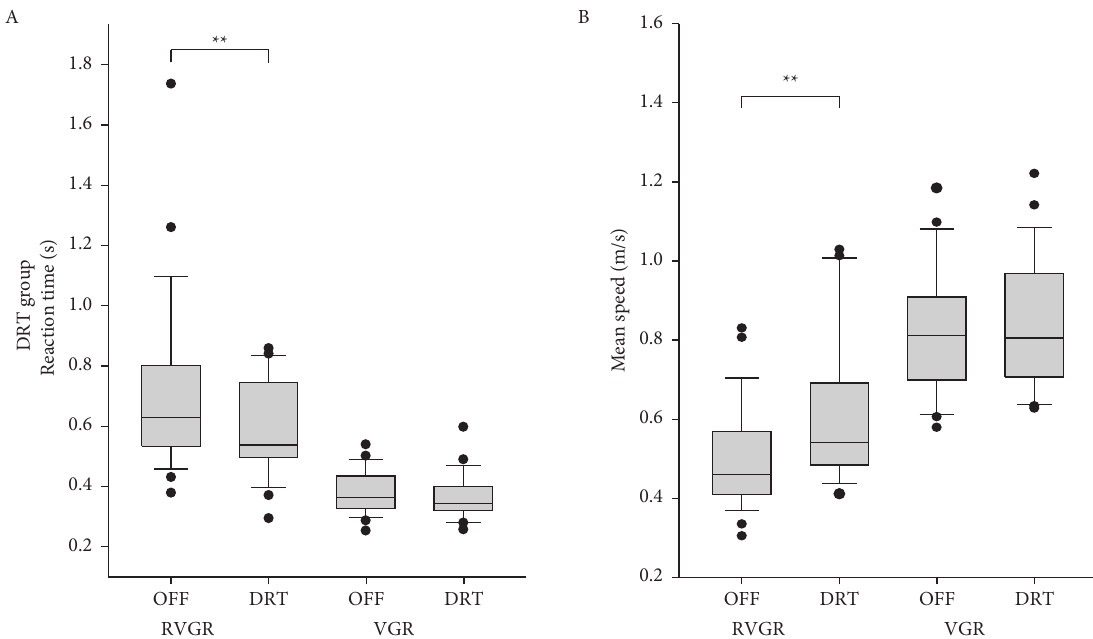
Figure 3: DRTgroup reaction time and mean speed changes with DRTadministration in the DRTgroup. (a) DRTadministration resulted in faster reaction times during RVGR ( ∗∗ P < 0 . 001). (b) DRT administration resulted in higher RVGR mean speeds ( ∗∗ P < 0 .